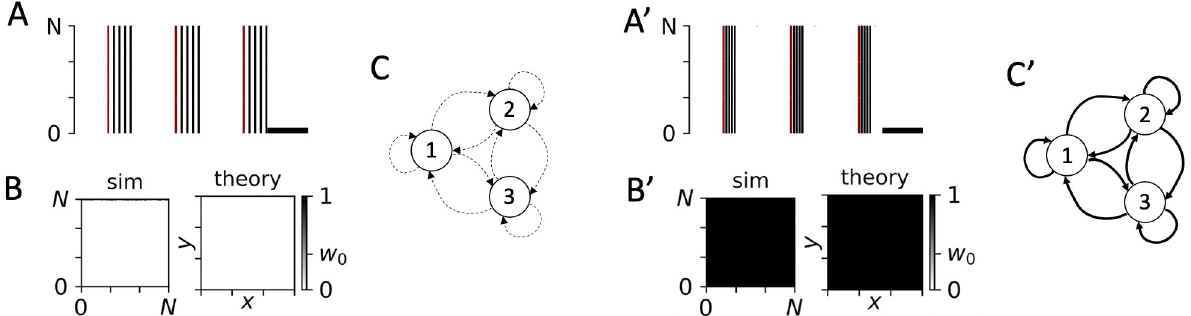
Fig 9. Periodic stimulation may either up-regulate or down-regulate all synapses depending on the employed type of stimuli. A: Raster plot of simulated spiking activity for PMCS with Δ α 1/2 = 0 and burst stimuli with low intraburst frequency. The scale bar indicates a time window of 100 ms. Stimuli are illustrated by red blocks. B: Snapshots of the simulated synaptic weight matrix after 1000 sec of stimulation (sim) and the corresponding theoretical prediction obtained from Eq 1 (theory). C: Schematic of stimulation-induced network structure. Circles represent subpopulations one, two, and three. Dashed arrows illustrate down-regulated synaptic connections. A’-C’: Same as A-C but for burst stimuli with high intraburst frequency. Thick arrows in panel C’ illustrate up-regulated synaptic connections. Parameters: A stim = 0.8, f = 5 Hz, and d e = 1 (all panels). An intraburst frequency of 60 Hz and five pulses per burst were used in panels A-C, and an intraburst frequency of 120 Hz and five pulses per burst were used in panels A’-C’.